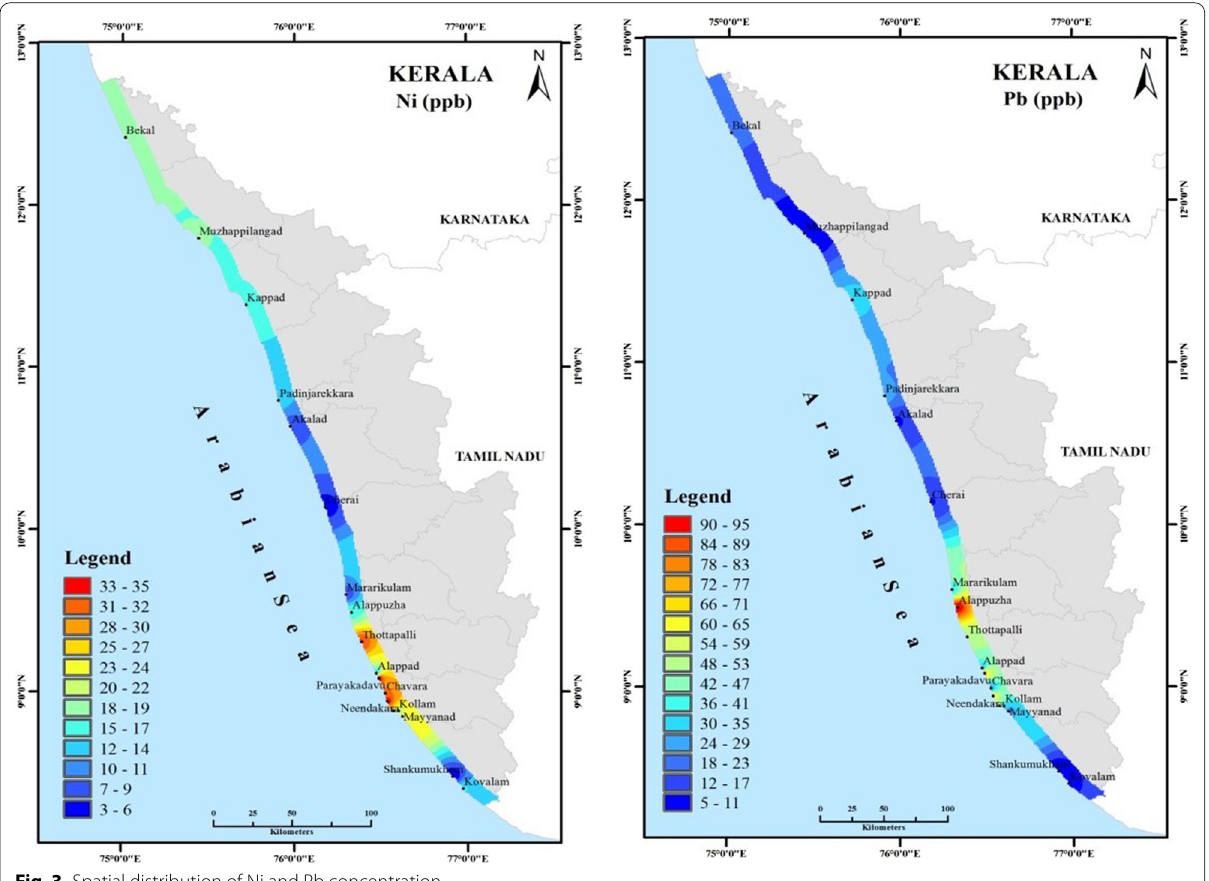
Fig. 3 Spatial distribution of Ni and Pb concentration